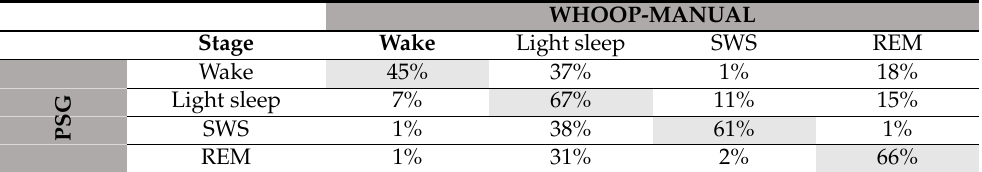
Table 4. Four-stage error matrix for WHOOP-MANUAL and